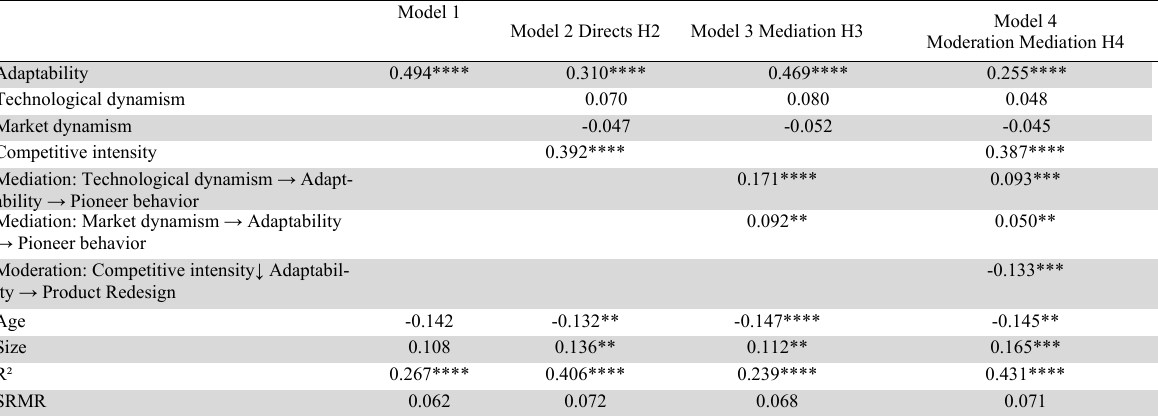
Comparative analysis of the research